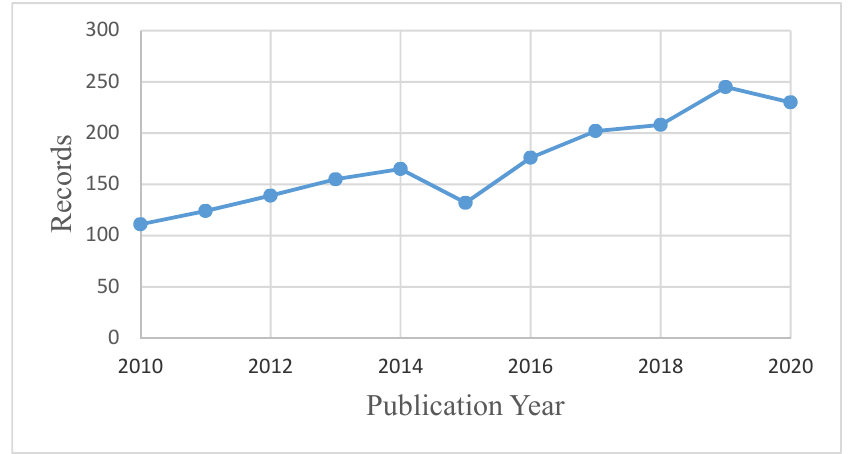
Figure 1. Publication trends in the field of gas turbine degradation.